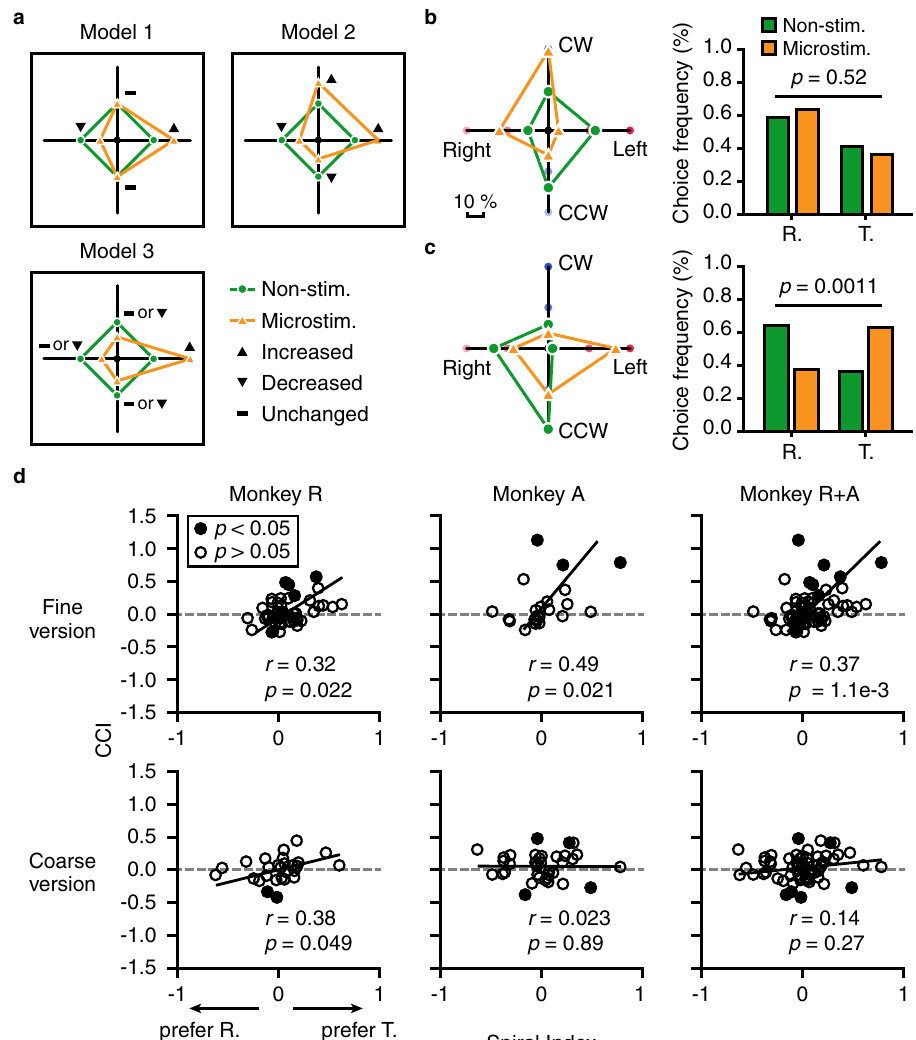
Fig. 6 | Microstimulation effect on choice between fl ow patterns. a Toy models illustrating three possible outcomes: Model 1, choice biased by microstimulation only within one fl ow pattern; Model 2, choice biased by microstimulation with respect to preferred stimulus within each fl ow pattern; Model 3, choice biased by microstimulation with respect to preferred stimulus within one fl ow pattern, and between fl ow patterns. Orange symbols, choices in microstimulation trial; Green